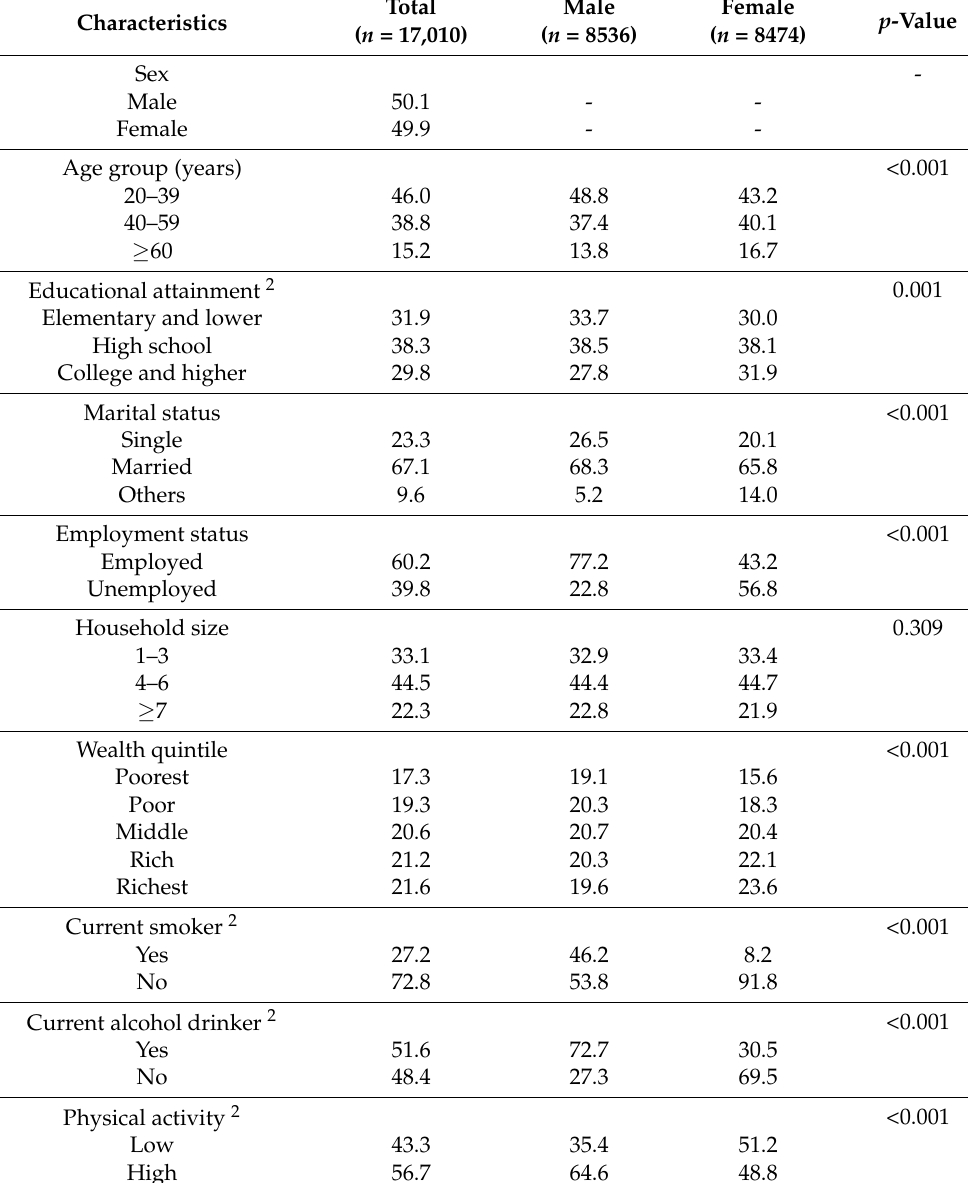
Table 1. Characteristics of study participants 1